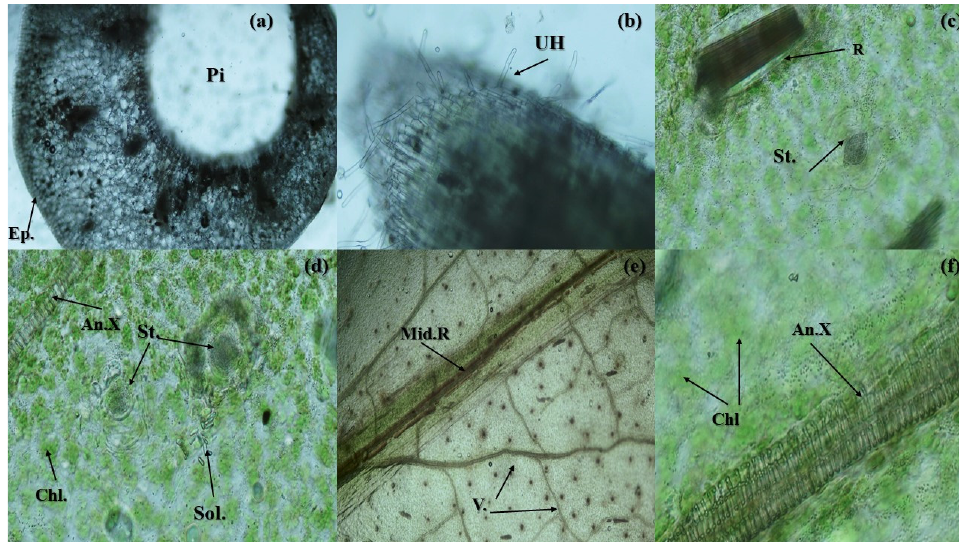
Figure 6. Anatomical features of Zantedeschia . (a) T.S in stem; (b) V.S in root; (c, d, e, f) T.S in leaf. The symbols refer to: Pi: pith, Ep.: Epidermis, UH: unicellular hair, R: raphides Ca. oxalate, St.: stomata, Chl.: chlorophyll pigmentation, An.X: annular xylem vessels, Sol.: solitary Ca. oxalate, Mid.R: mid-rib, V.: lateral veins. (BAUSCH&LOMB, 150X power).